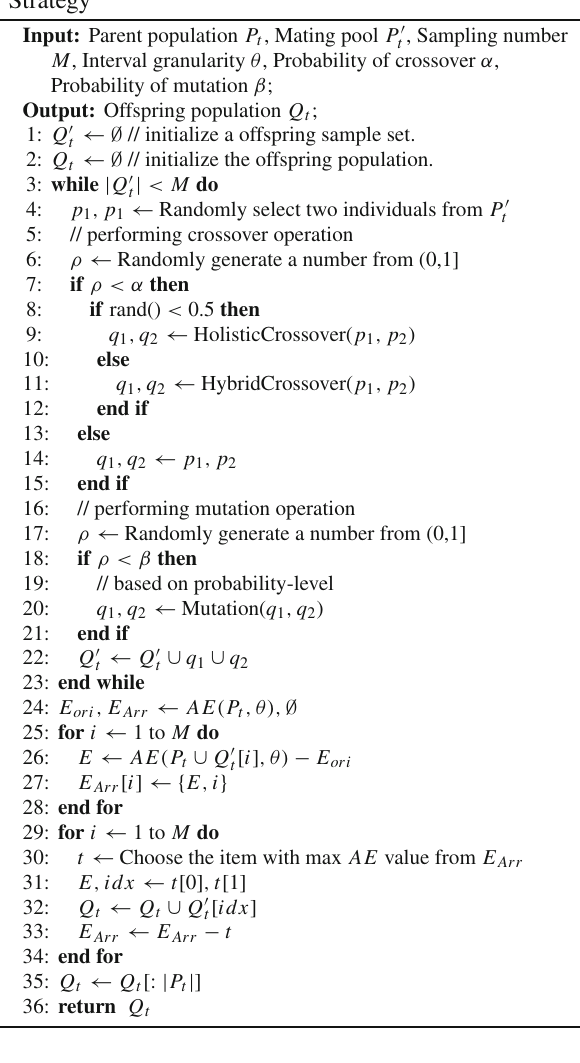
Algorithm 2: Architecture Entropy Based